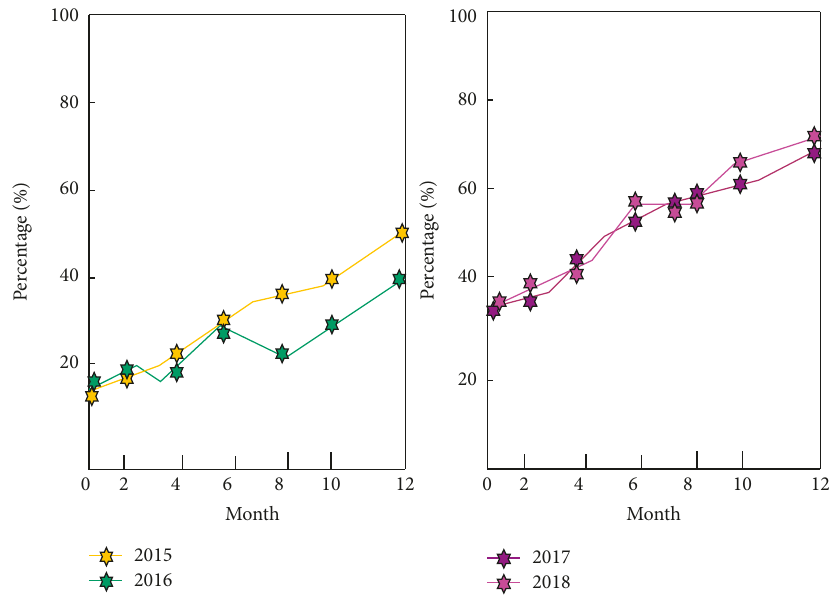
Figure 8: Development trend of 3D technology from 2015 to 2018. Table 3: Basic information of survey respondents.